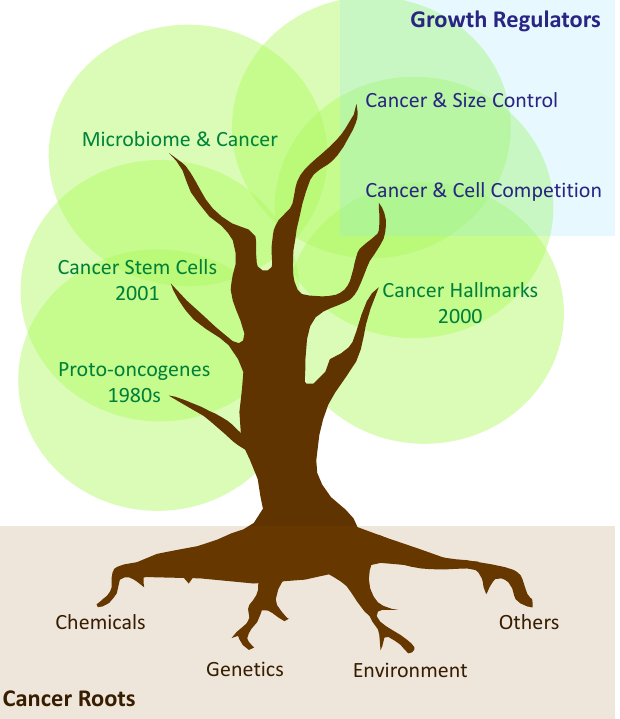
Figure 1. Cancer roots and growth regulators . Tree chart depicting known origins of cancer (brown), timeline of key discoveries in cancer research (green), and growth regulators during tumoral growth